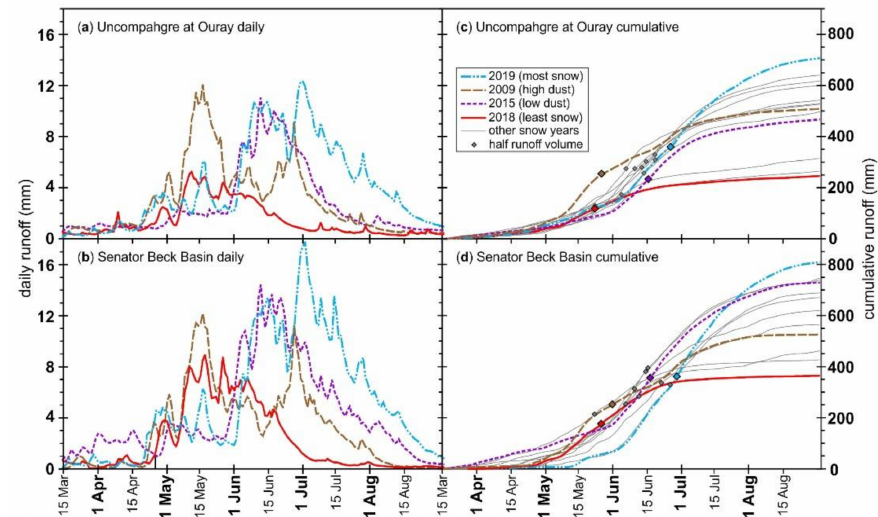
Figure 7. Daily runoff for the two extreme snow year (low 2018 and high 2019) and the two focus years (shortest ∆ SAG 2015 and longest ∆ SAG 2009) at the ( a ) Uncompahgre River at Ouray and ( b ) Senator Beck Basin streamflow gauging stations, and cumulative runoff for all years at ( c ) Uncompahgre River at Ouray and ( d ) Senator Beck Basin. The cumulative runoff plots include the half runoff volume date (t Q50 ).